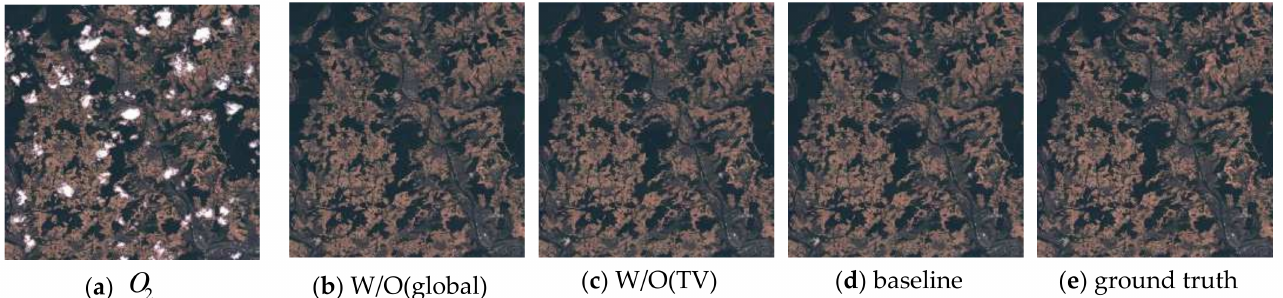
Figure 7. Results of ablation models about loss